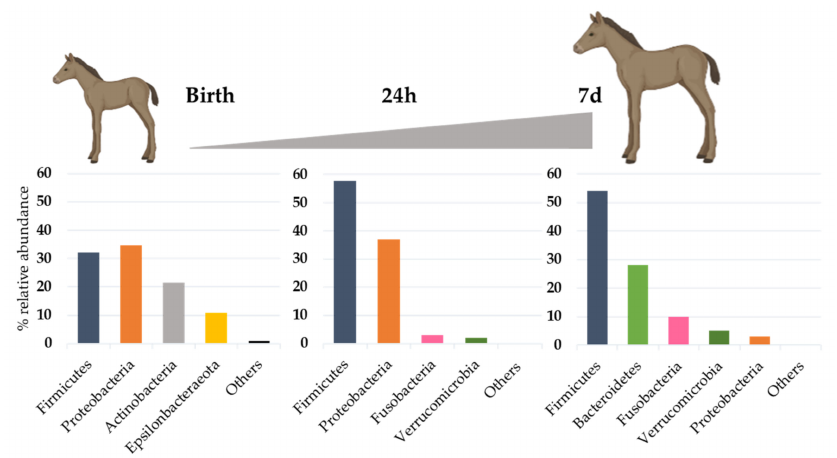
Figure 3. Evolution of the main bacterial phyla in foal rectal samples from birth to 7 days of age. After